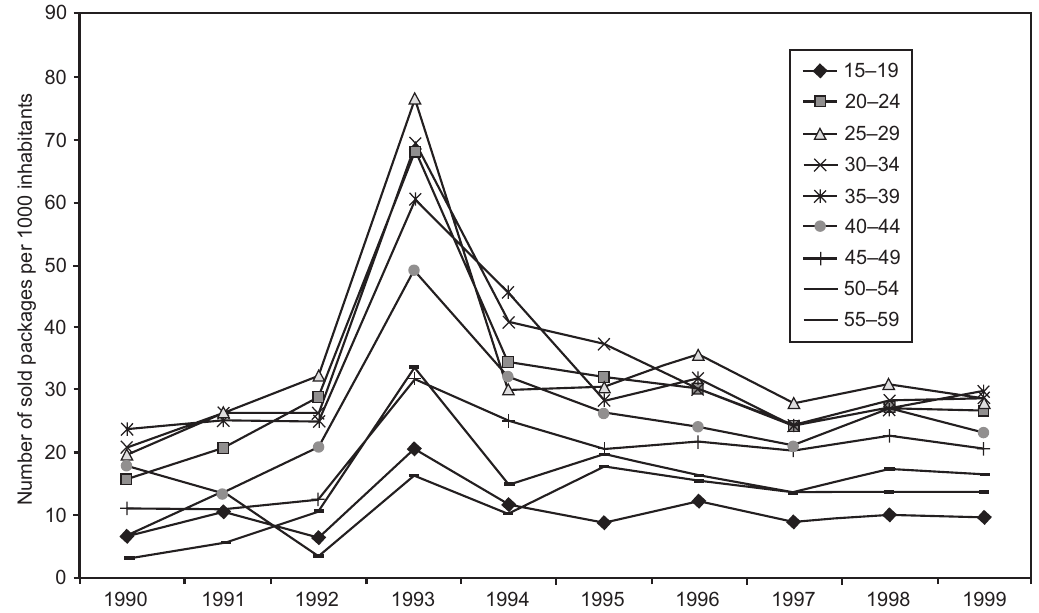
Figure 3 Number of prescriptions of one capsule of 150 mg fluconazole (Diflucan 1 ) sold per age group in Ska˚ne county, Sweden, during the 1990s